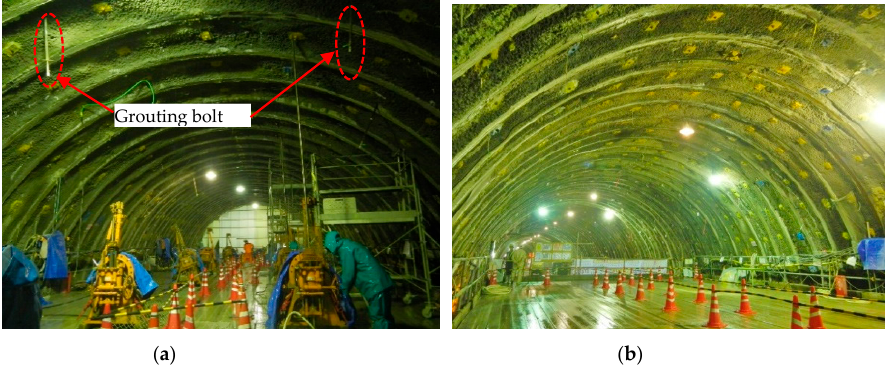
Figure 17. The effect of the new grouting method. ( a ) The grouting process; ( b ) the effect after grouting.